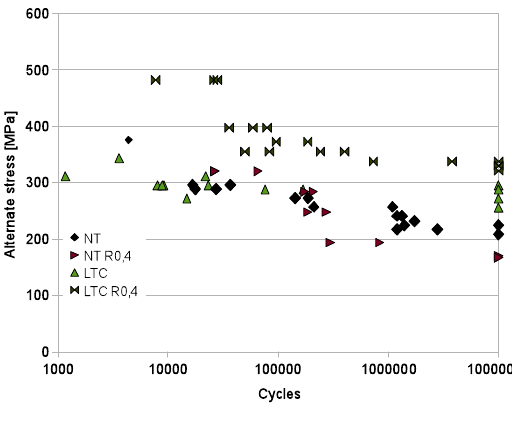
Fig. 5: Apparent notch